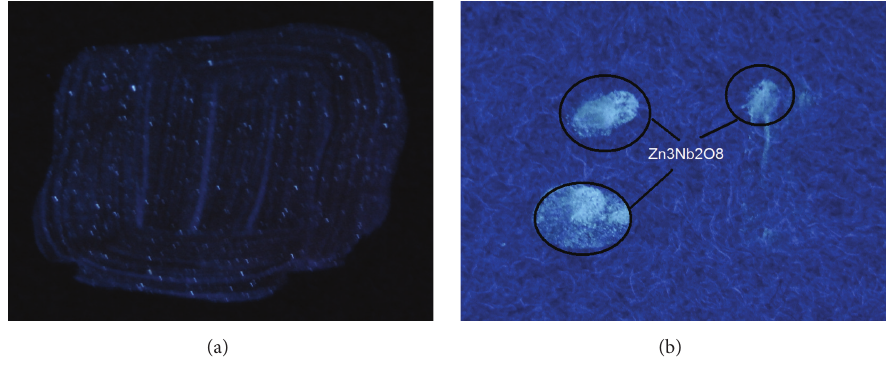
Figure 5: Zn 3 Nb 2 O 8 in (a) acrylic based paint and (b) isopropyl